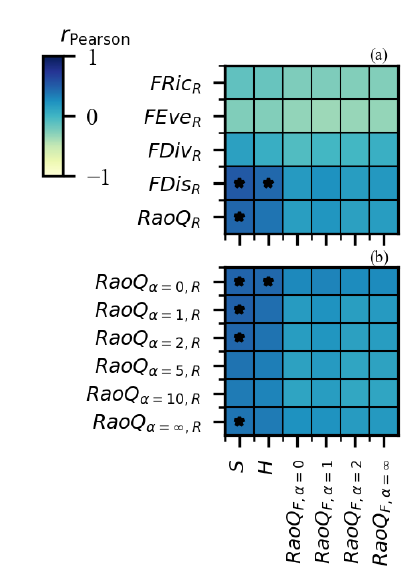
Figure 3 . Pearson correlation between field and remote sensing (reflectance factors-based) metrics. Asterisks indicate 307 significant relationships at 95 % of confidence. Functional diversity metrics computed from the vegetation parameter estimates (Figure 4) obtained via RTM inversion showed no significant correlations with field functional or taxonomical metrics. Still, similar patterns of correlation than those observed for reflectance factors-based metrics (Figure 3), except for FRic , which presents relatively stronger correlations than FEve or FDiv this time. Maximum Pearson correlation coefficients were 0.53 for the dbFD package metrics (Figure 4a) and 0.48 for the parametric Rao’s Q indices (Figure 4b).